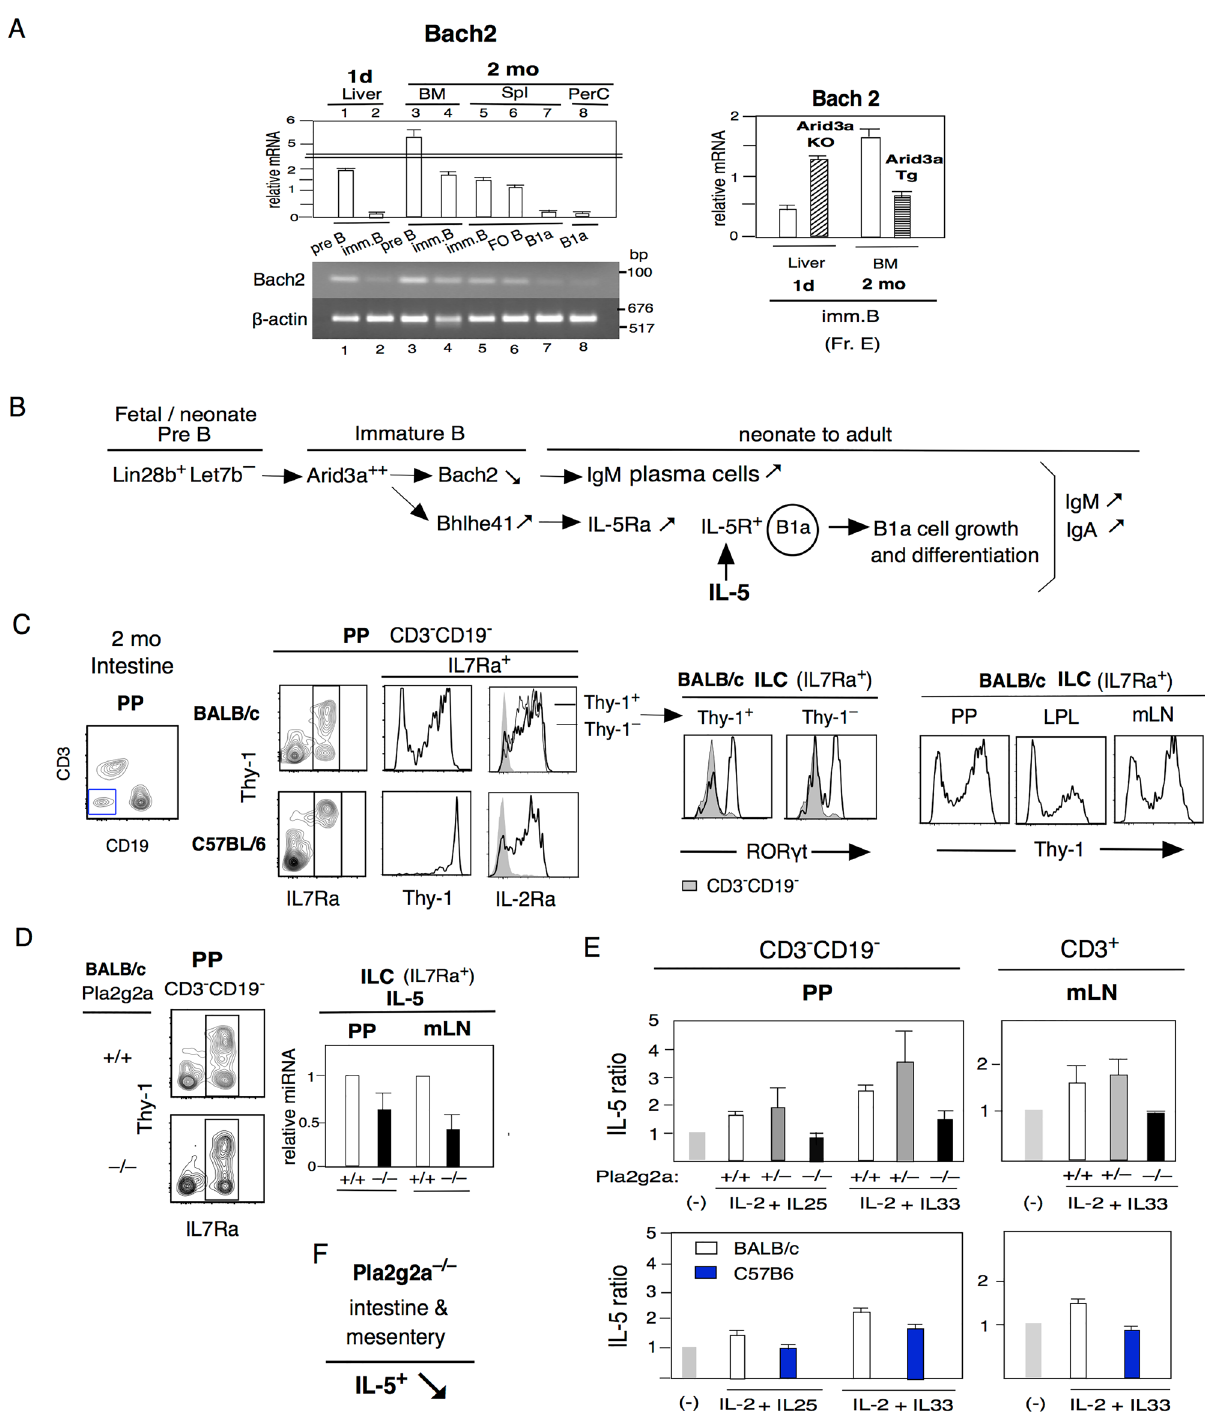
Figure 2. Pla2g2a loss leads to reduced IL-5. Bach2 lo allows IgM and IgA secretion and the presence of IL-5 allows IL-5R + B1a cell growth and differentiation, as described in ( B ). ( A ) Analysis of early-generated B1a cell Bach2 levels. Left: Bach2 qRT-PCR of B-lineage 1d liver pre B (Fr.D) and immature B (Fr. E; B220 + IgM + AA4.1 + ) and 2 mo BM pre B and imm. B with spleen imm. B (AA4 + ), FO B, B1a cells, and PerC B1a cells in C.B17 (n = 5 each; mean ± SE). Bach2 RT-PCR compared with β-actin. Right: Bach2 qRT-PCR in Fr. E in wild type versus Arid3a KO mice in 1d liver, and wild-type versus Arid3a Tg in 2 mo BM (n = 3 each; mean ± SE). ( B ) Arid3a ++ outcomes are Bach2 low and increased Bhlhe41. Bhlhe41 hi leads to an IL-5Ra increase in B1a cells, with an IL-5-IL-5R reaction. ( C ) Left: 2 mo intestine ILC (CD3 – CD19 – IL7Ra + ) cell analysis by BALB/c and C57BL/6 mice in PP, with Thy-1, IL-2Ra, and RORγt (ILC3). ILCs were 36% in BALB/c mice and 17% in C57BL/6 mice in the CD3 - CD9 - population. Right: Thy-1 – ILCs in PP and LPC in the intestine and in mLNs in BALB/c mice. ( D ) IL-5 mRNA analysis of IL7Ra + ILCs in PPs and mLNs between Pla2g2a + / + and –/– BALB/c mice (n = 3 each; mean ± SE). + / + mice were used as the control. ( E ) IL-5 analysis from PP CD3 - CD19 - cells with IL-2 + IL-25 and IL-2 + IL-33 stimulation in Pla2g2a + / + , + /–. –/– mice (n = 3 each; mean ± SE), and BALB/c versus C57BL/6 mice (n = 2; mean ± SE). mLN CD3 + T cells stimulated IL-2 + IL-33 in these mice. Nonstimulated outcome (-) is the control. ( F ) Pa2g2a –/– decreased IL-5